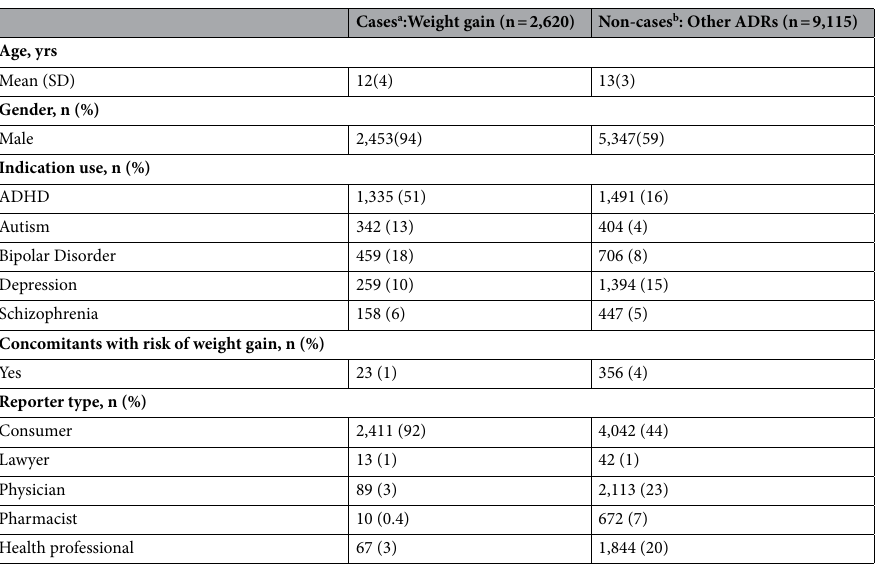
Table 3. Characteristics of cases and non-cases included in the pharmacovigilance analysis. ADHD Attention deficit hyperactivity disorder, ADR adverse drug reactions, CI confidence interval, N number, ROR reporting odds ratio, SD standard deviation, yrs years. a Pediatric report (5–17 years old) involving at least one antidepressant/antipsychotic agent in the occurrence of weight gain. b Pediatric reports (5–17 years old) involving at least one antidepressant/antipsychotic agent in the occurrence of any type of adverse drug reactions.